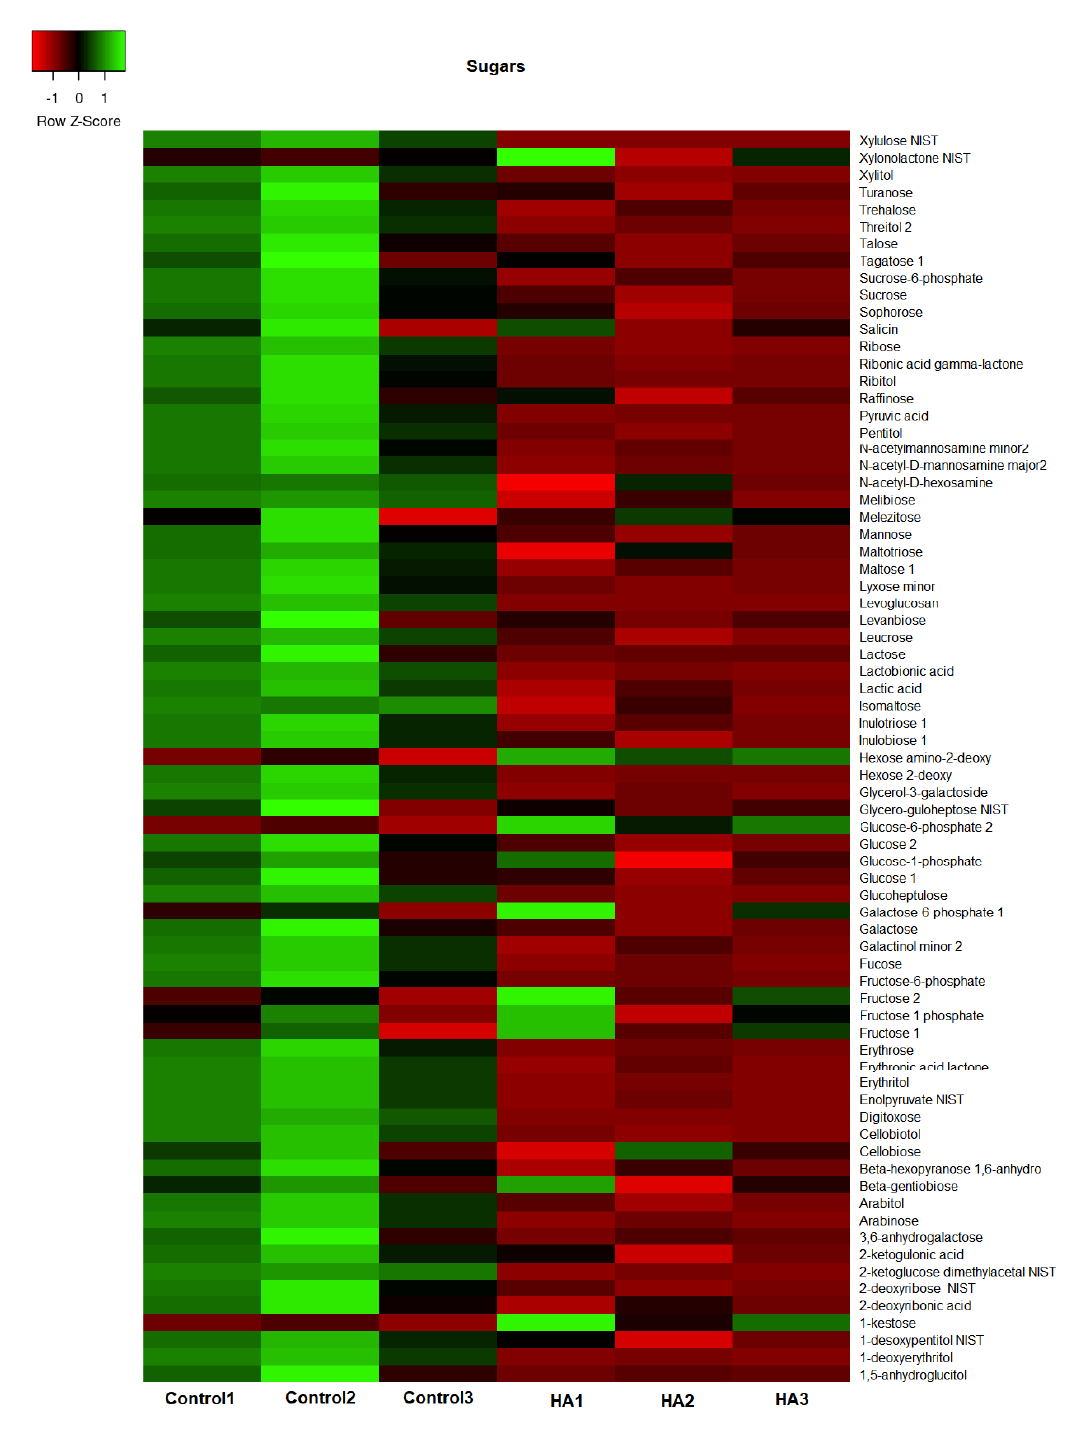
Figure 4. The concentration map of carbohydrates (heat map of scaled concentrations) by plants treated with humic acids (HA) or not (Control) .